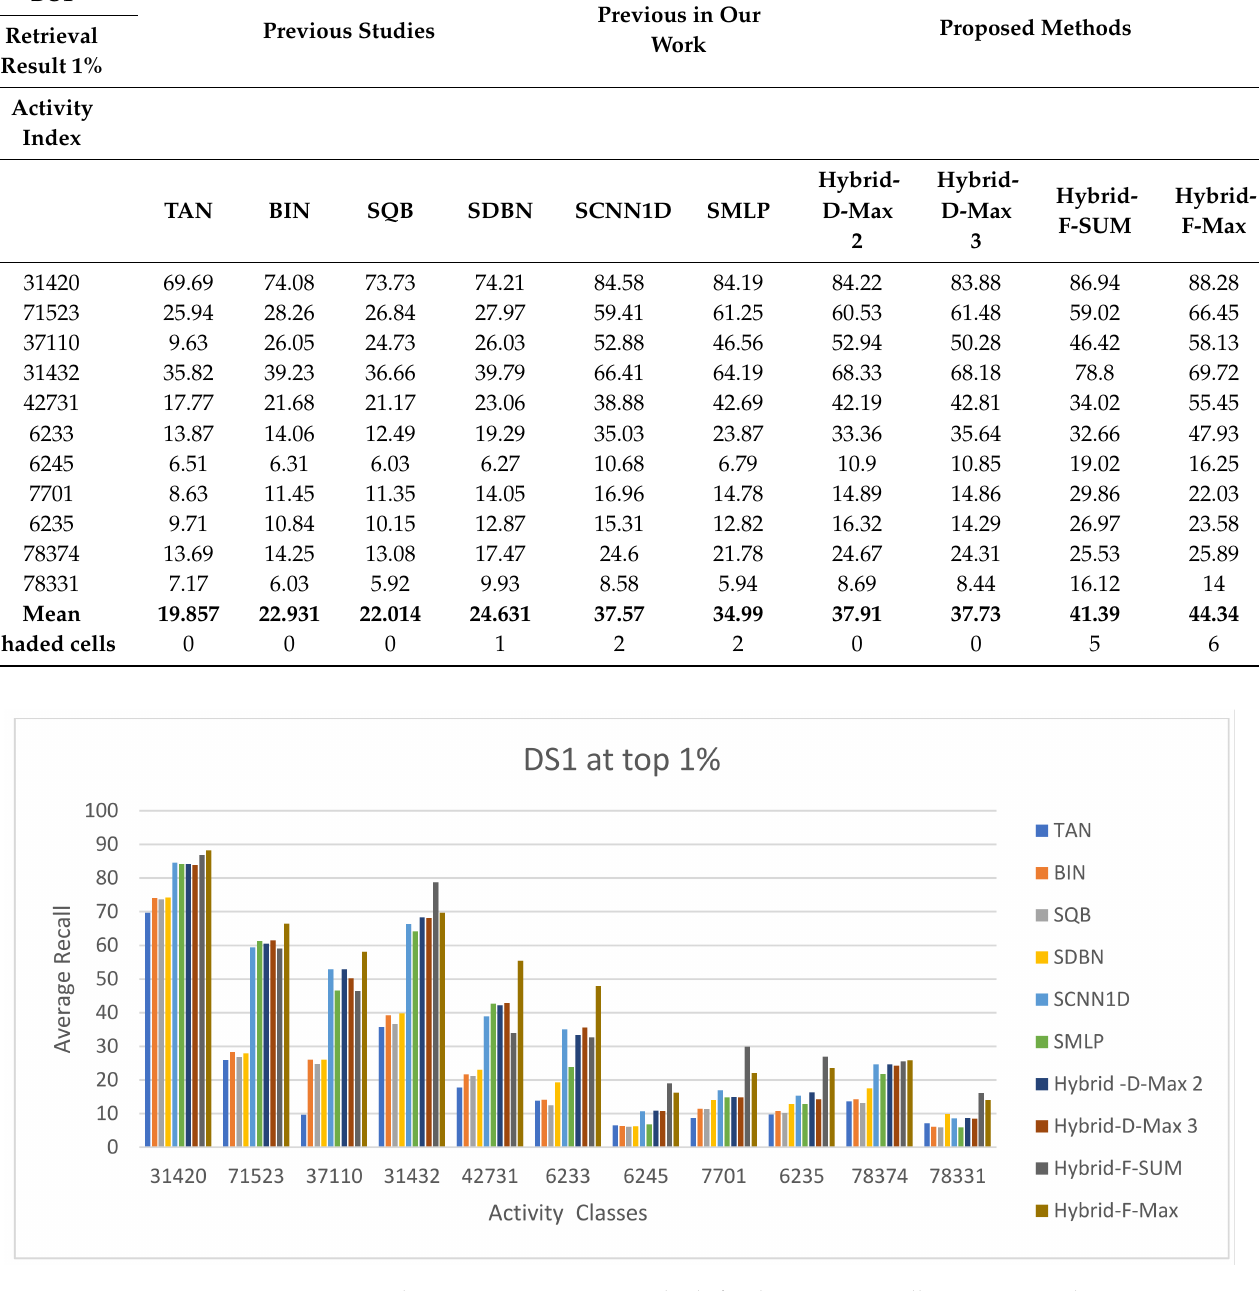
Figure 8. The comparison among methods for the average recall percentage at the top 1% in MDDR- DS1 (homogeneous and